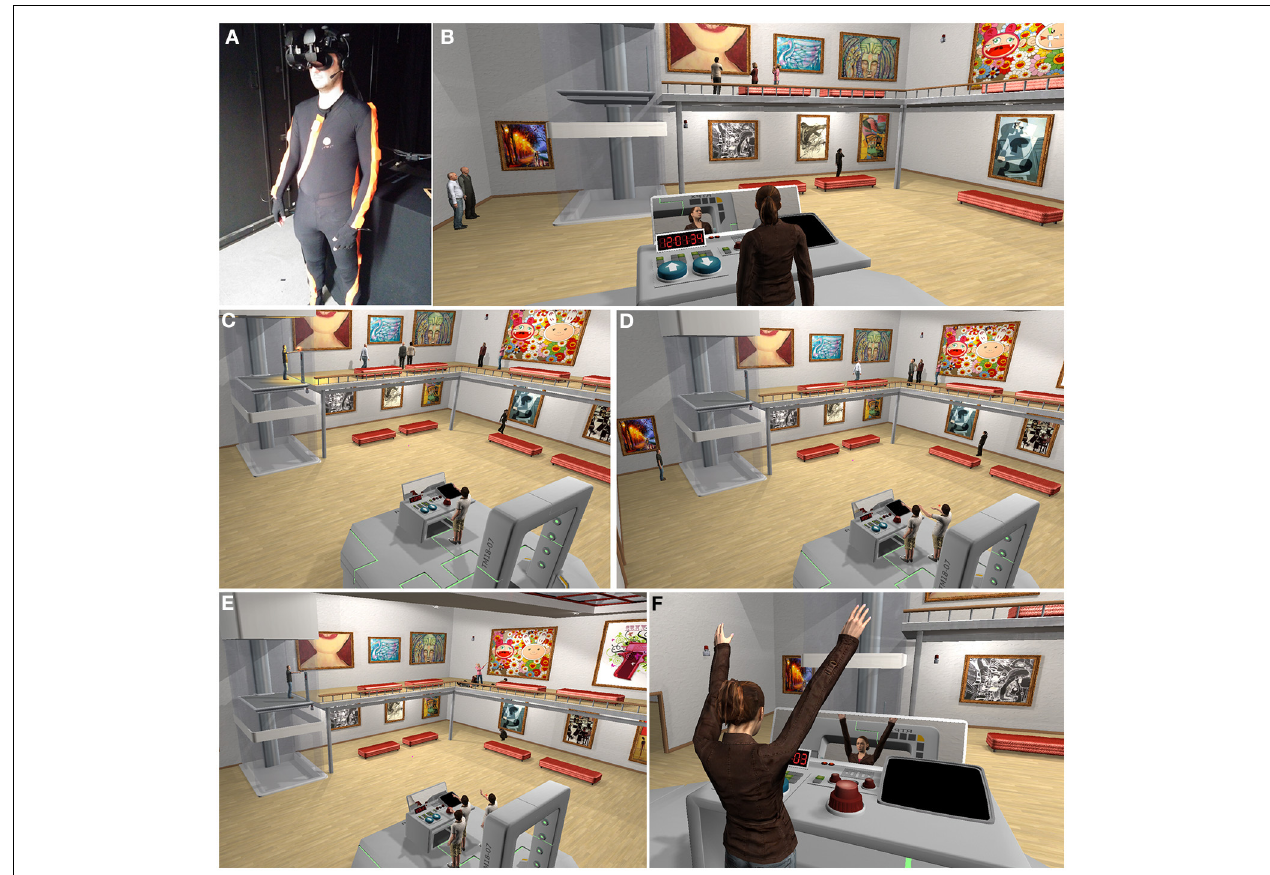
FIGURE 1 | The gallery room scenario. (A) A participant wearing the head-mounted display and the motion capture suit. (B) The gallery with three visitors at the upper level, 1 on the ground level, and 2 waiting to be taken up. The workbench is shown with the up and down elevator control buttons and the red alarm button. The mirror reflects the virtual body of the participant (here female), which can also be seen from behind. The participants saw the environment from the first person perspective of the body, and the virtual body was coincident in space with their real body. (C) The gunman shoots at the five people on the upper